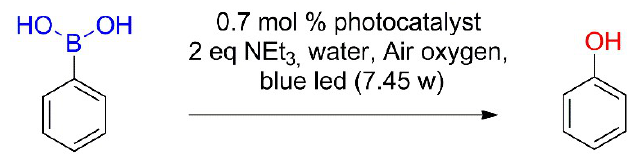
Scheme 2. Photoredox hydroxylation of phenylboronic acid.